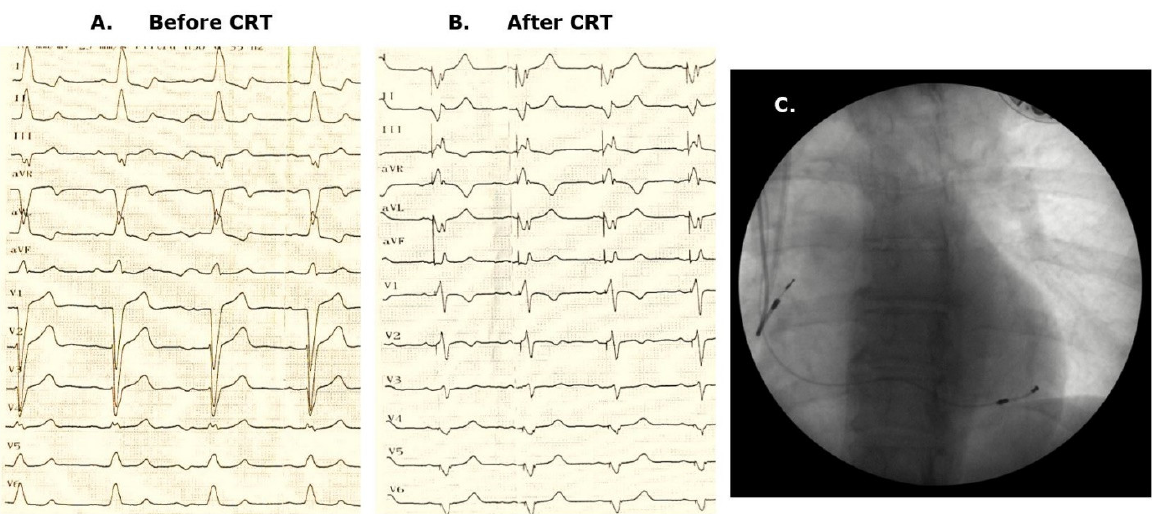
Figure 3. ( A ) . ECG before CRT—typical LBBB morphology with a QRS of 160 ms. ( B ). ECG after fusion CRT-P: a thinner QRS can be easily noted, with an rS morphology in V1 and V2, and a QS morphology in the left leads. ( C ) . Posterior-anterior fluoroscopy image: CRT DDD pacing system with 2 leads in the right atrium and a lateral branch of the coronary sinus.